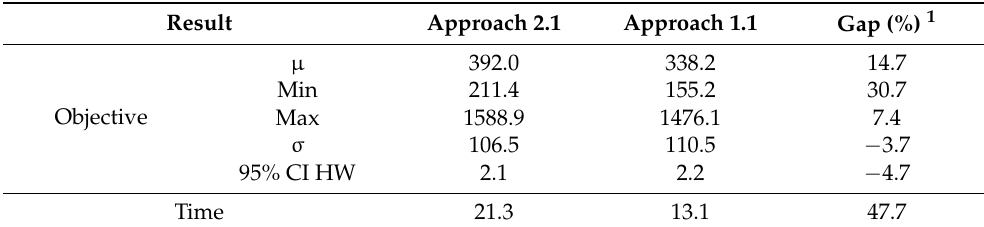
Table 9. The gap between the solutions and the run times (in hours) of the SDSMO model with and without clustering.